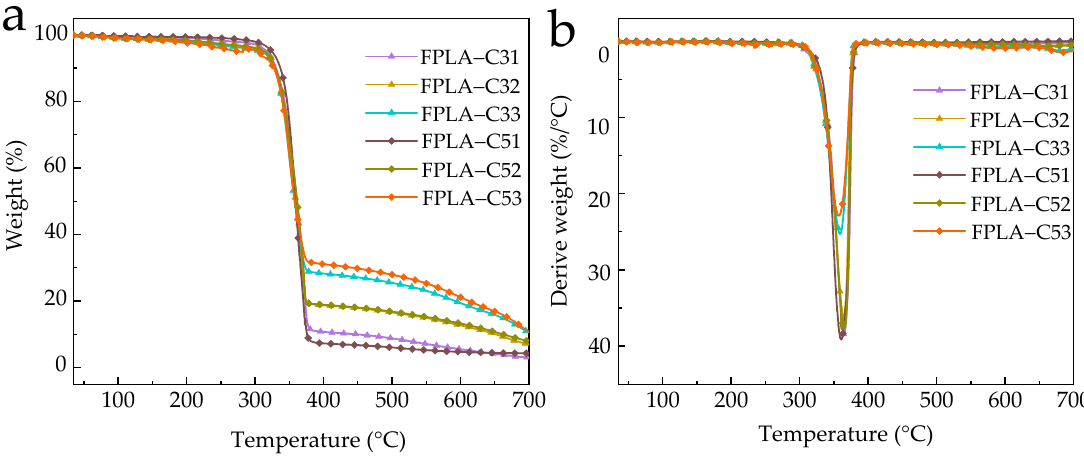
Figure 9. TGA ( a ) and DTG ( b ) curves of FPLA composites in air. Table 5. TGA data of FPLA composites under air condition.